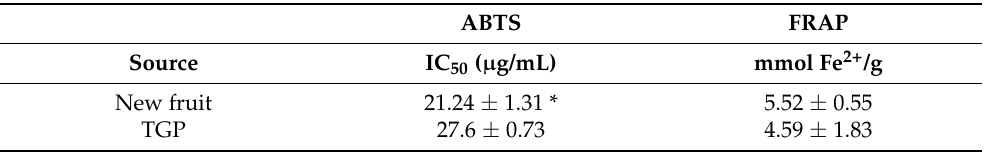
Table 4. Antioxidant activity of TGP and the surface material extract of M. tanarius new fruit in scavenging ABTS radicals and reducing ferric (Fe 3+ ) ion.